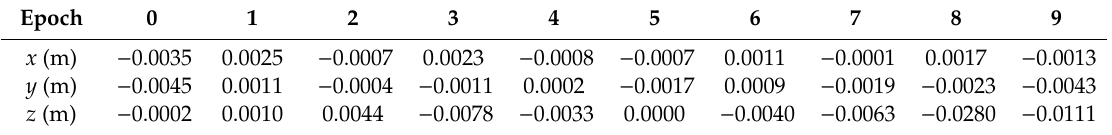
Figure 3. The discussed longwall panel excavation in the observation area. Table 1. Average mean errors in x, y, and z directions for each epoch.